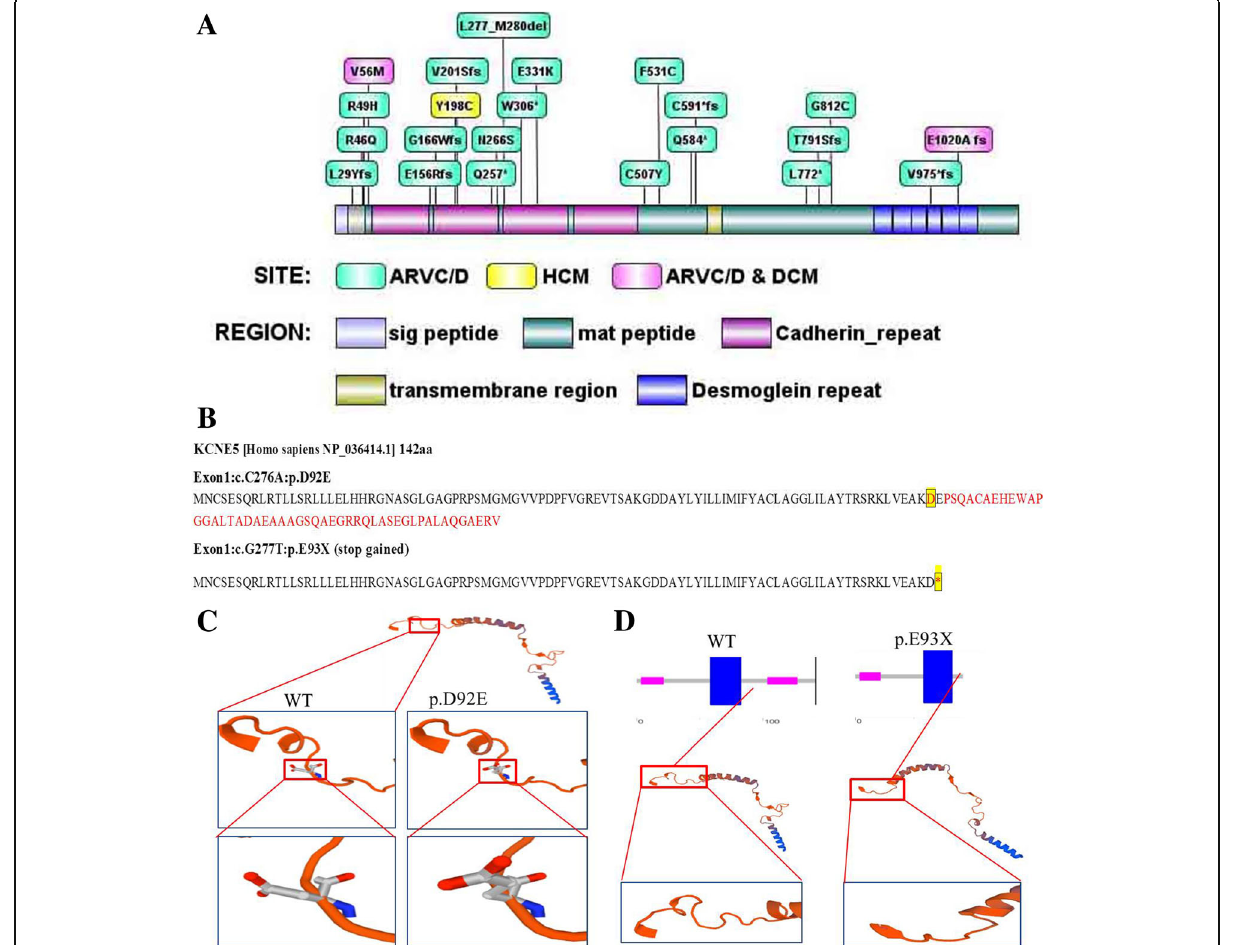
Fig. 4 Pathogenic mutations in the DSG2 protein and structure of KCNE5 mutations. a secondary structure of DSG2 protein (NP_001934.2), which consists of 1118 amino acids. The pathogenic mutation related to ARVC/D, hypertrophic cardiomyopathy (HCM) and dilated cardiomyopathy (DCM) were displayed according to PubMed ClinVar and recent reports from PubMed. b - d primary ( b ) and tertiary ( c – d ) structure changes of KCNE5 p.D92E/E93X mutation and wildtype of KCNE5, constructed by Swiss-model. *,